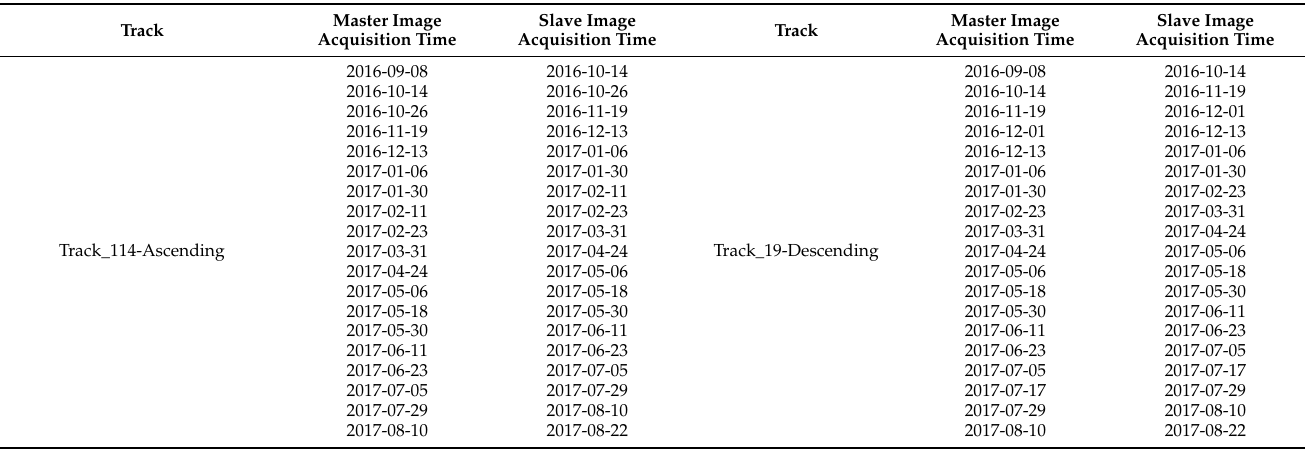
Table A1. Sentinel-1 image pairs used on Urumqi Glacier